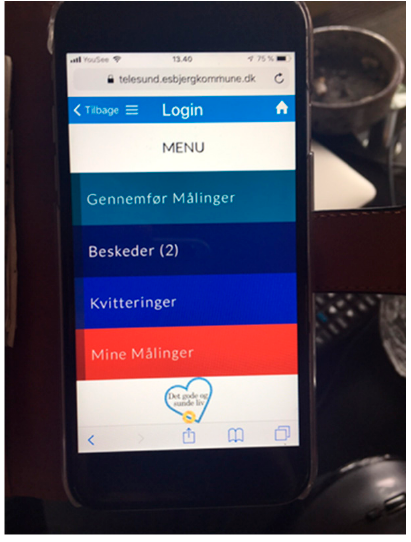
Figure 2. App user interface, information.